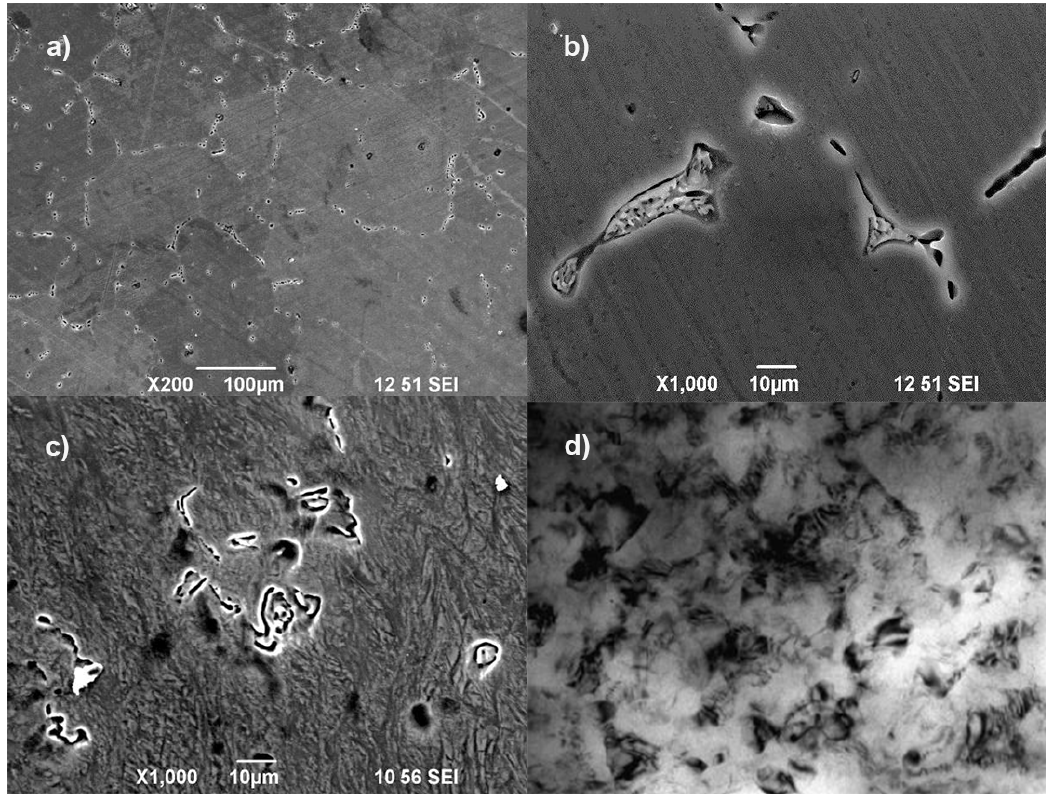
Figure 5. Microstructures of Mg-1Ca alloy: ( a , b ) scanning electron microscopy images of CG alloy; ( c , d ) transmission electron microscopy images of NC alloy. Reprinted with permission from Ref.